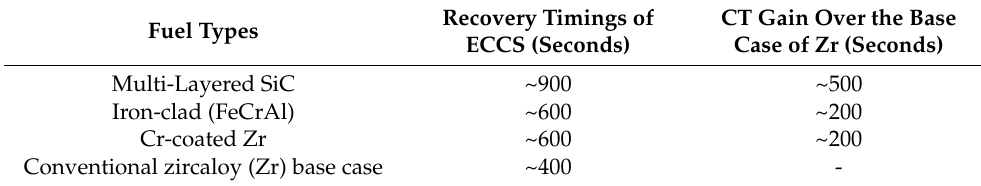
Figure 11. Recovery time for ECCS (time from ECCS actuation signal) with ATF fuel types: ( a ) Multi-layered SiC; ( b ) Iron-clad (FeCrAl); ( c ) Conventional Zircaloy (Zr); ( d ) Chromium-coated Zircaloy (Cr-coated Zr). Table 5. Coping time of different fuel types concerning the recovery of active